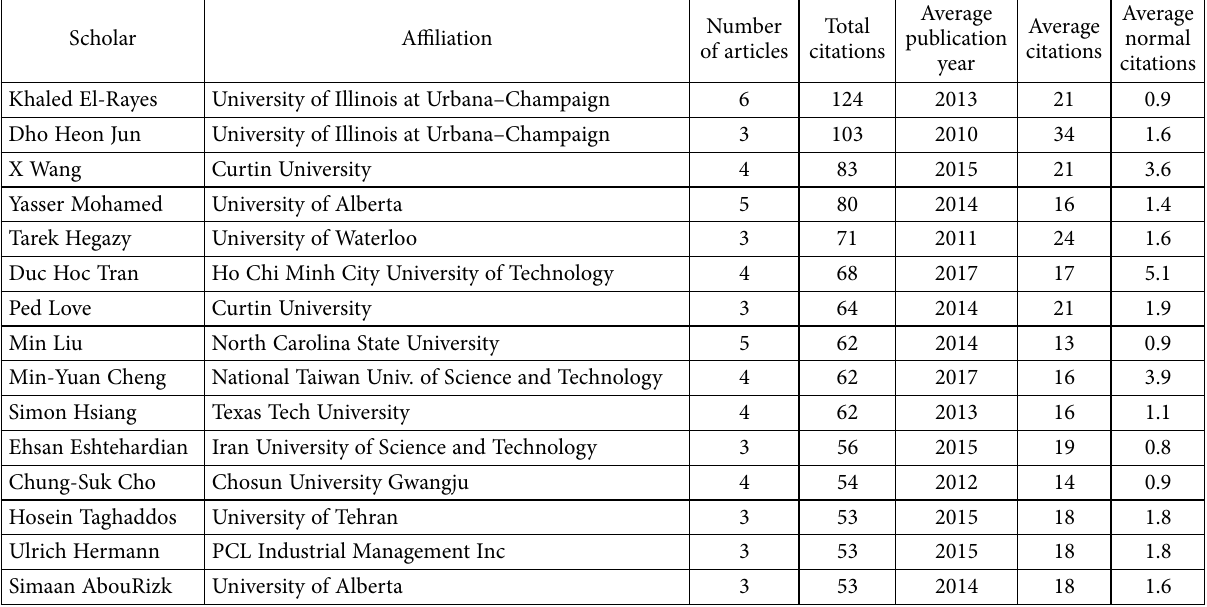
Table 4. Summary of measurements for co-authorship in CPS research